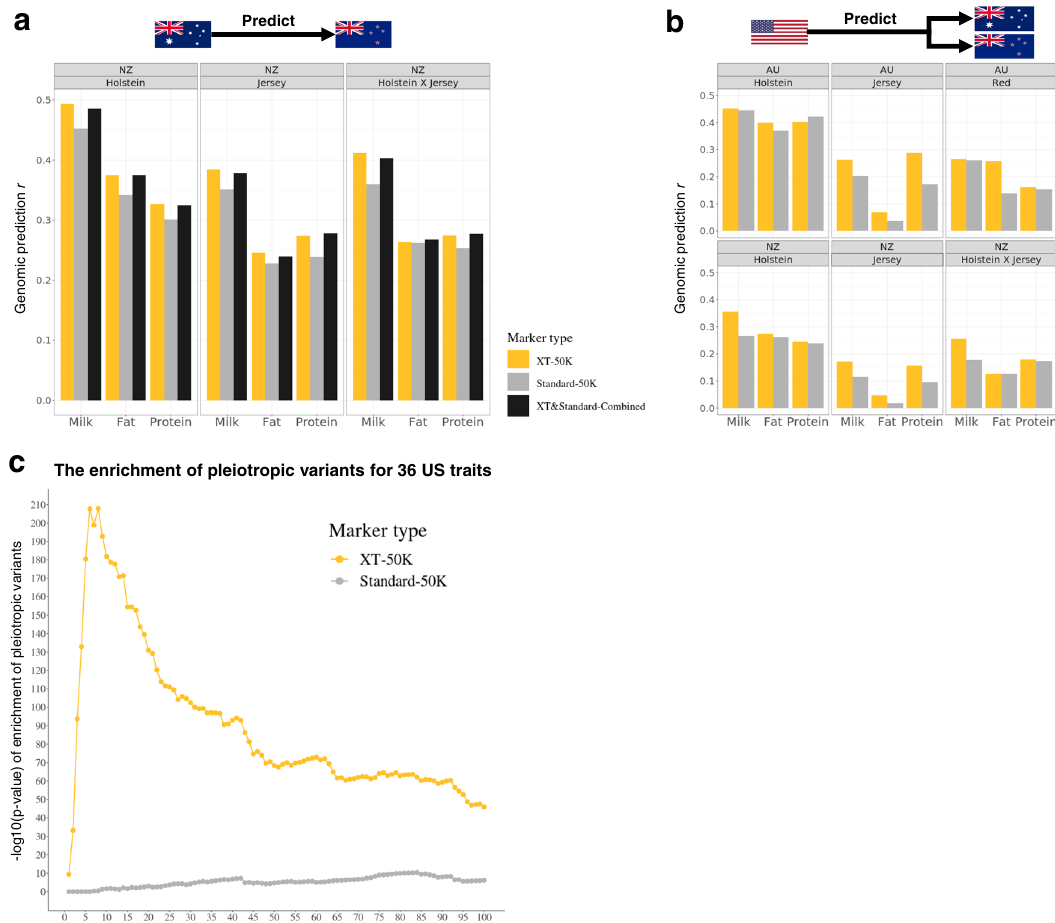
Fig. 5 Comparing customized XT-50K markers with the Standard-50K markers in multiple validation cow sets. a BayesR genomic prediction trained in an independent set of 28.2k multi-breed Australian cows for three traits and predicted into 21.2k New Zealand cows (pure- and crossbreds). XT&Standard- Combined: combined markers from the XT-50K and Standard-50K panels. b Genomic prediction using a subset of markers from the two 50 K panels that are also found in the US 36-trait GWAS using 27.1k Holstein US bulls for the same three traits and predicted into 28.2k Australian cows and 21.2k New Zealand cows. The US GWAS excluded intergenic and intronic variants 29 and their sequence variant imputation was based on Run 5 of the 1000 Bull Genomes project 4 . c The enrichment of pleiotropic variants from the US 36-trait GWAS in the two 50K panels. Note that only 19 of 36 US traits were present in the 34 Australian traits used to prioritise the XT-50K markers (Supplementary Table 3). X -axis: multi-trait p -value thresholds (0 – 100 on − log 10 scale) used to select signi fi cant pleiotropic variants for USA traits. Y -axis: the signi fi cance of enrichment (hypergeometric test) of pleiotropic variants for USA traits based on the number signi fi cant variants at each multi-trait p -value threshold ( X -axis) within the XT-50K markers and within the Standard-50K